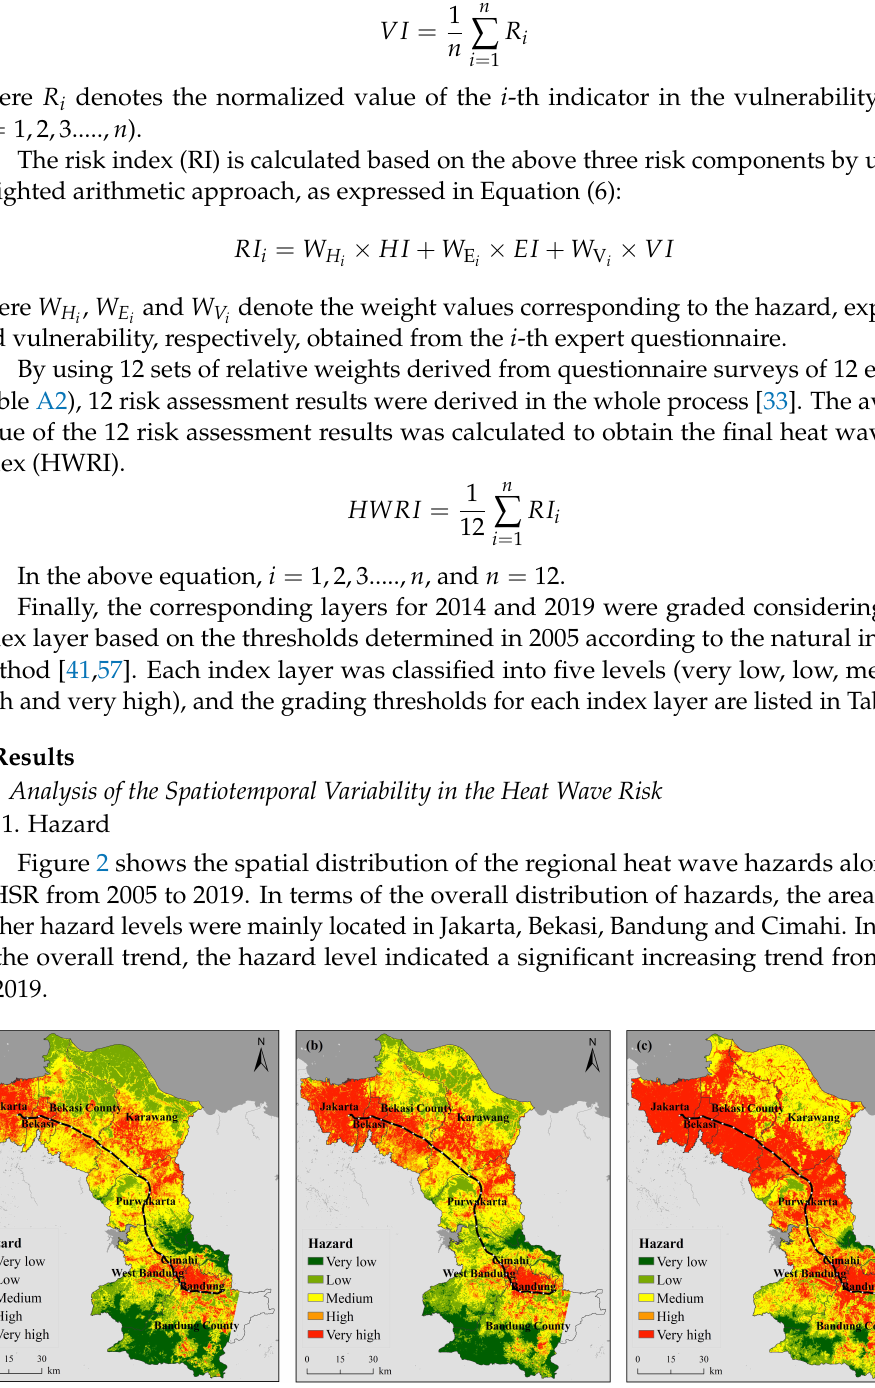
Figure 2. Spatiotemporal variation in the heat wave hazard (( a ) 2005, ( b ) 2014, ( c ) 2019). Combined with Table A4, it is found that the proportion of very high-level hazards changed the most, increasing from 13.66% in 2005 to 39.48% in 2019, which is an increase of 25.82% over the past 15 years. The remaining four grades of hazards all indicated varying degrees of decreasing